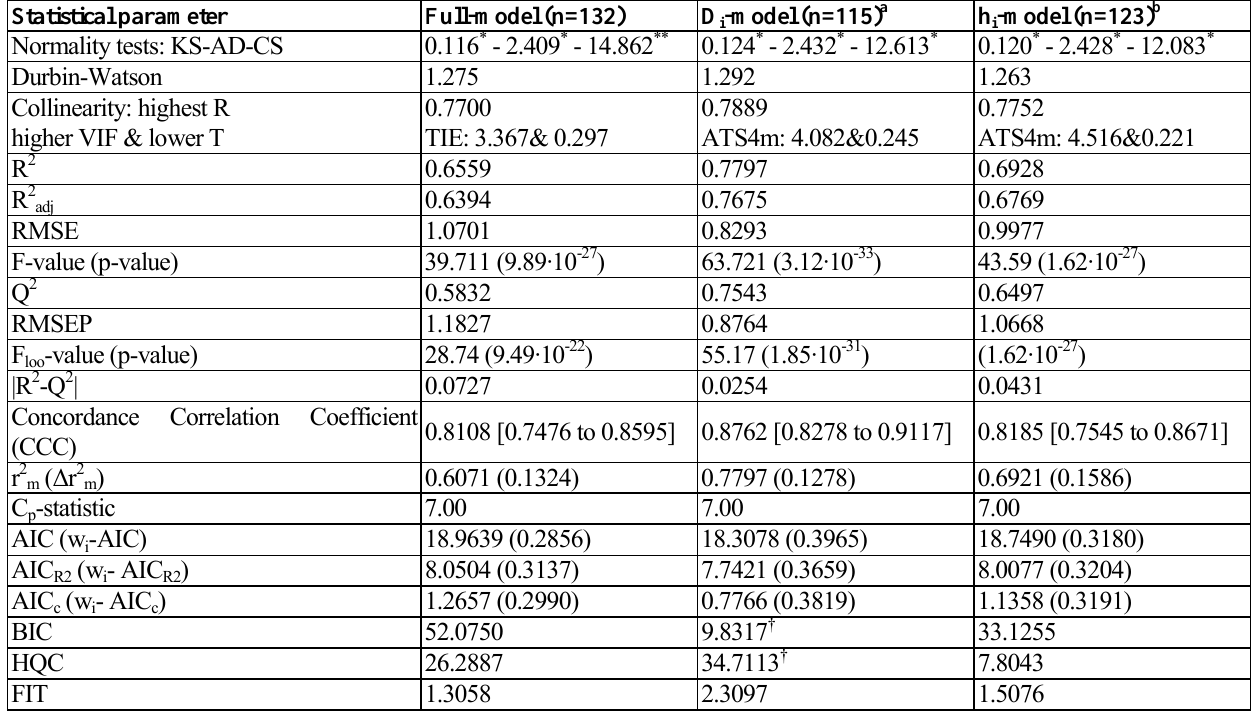
Statistical parameter Full-model